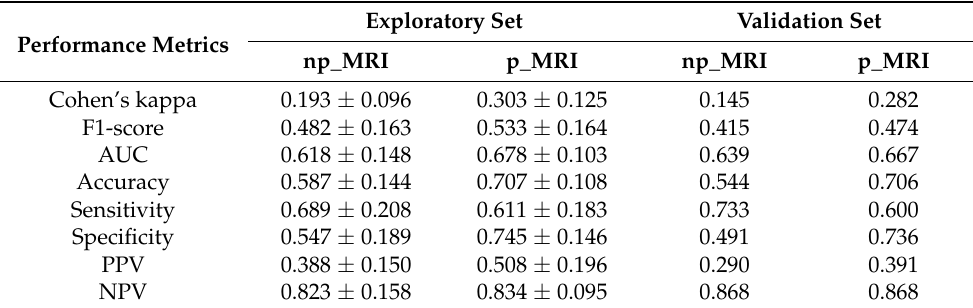
Table 2. Performance of np_MRI and p_MRI radiomics in isocitrate dehydrogenase (IDH) mutation status